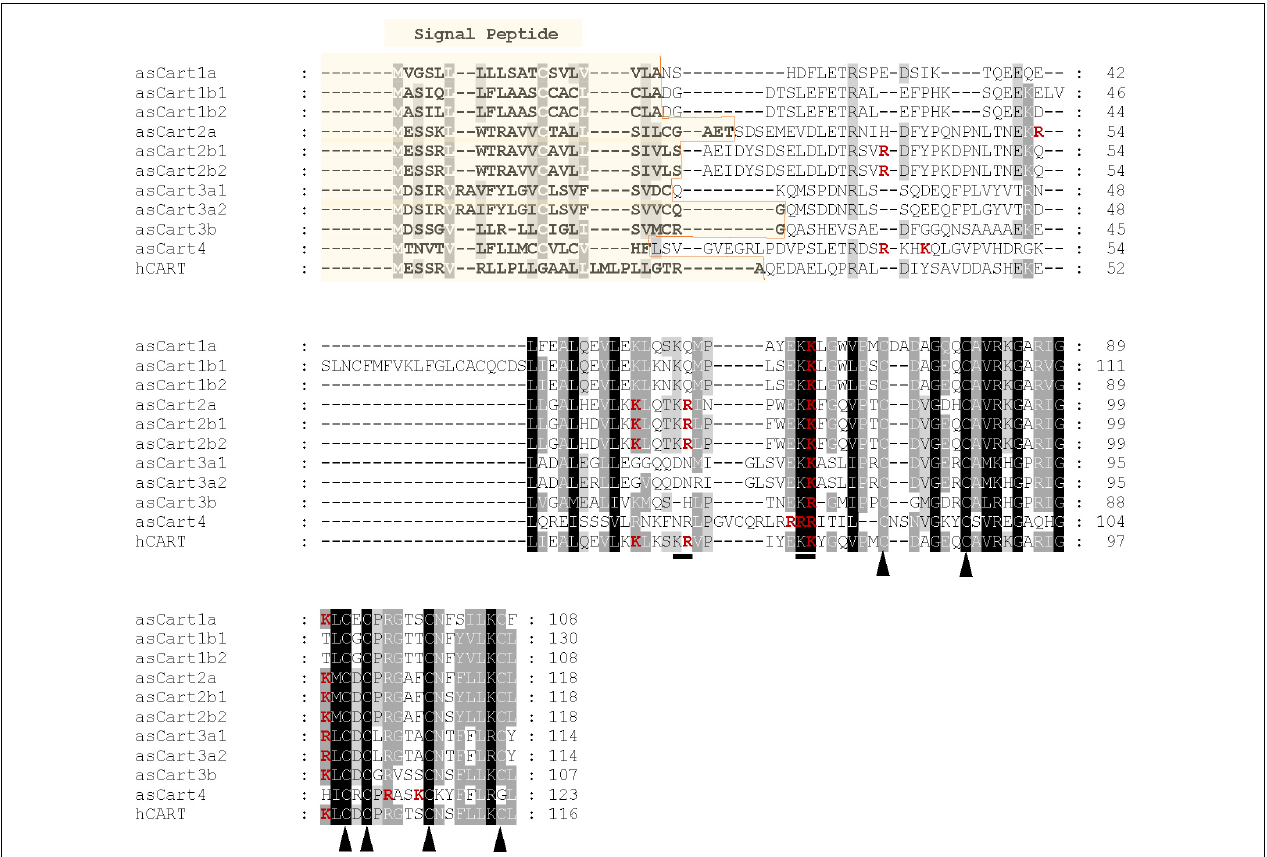
FIGURE 2 | Multiple sequence alignment of Atlantic salmon (as) and human (h) Cart amino acid sequences obtained by using ClustalX 2.1 and edited in GeneDoc 2.7 software. Black areas indicate 100% and shaded areas indicate > 60% conserved amino acid residues among the Cart sequences. The putative signal peptide is highlighted in yellow. Potential proteolytic processing sites KK and KR for hCART are underlined with thick lines and marked in red bold letters are the predicted sites for Cart using Neuropred application. Arrowheads indicate the conserved 6 cysteine residues that forms the disulfide bond in human